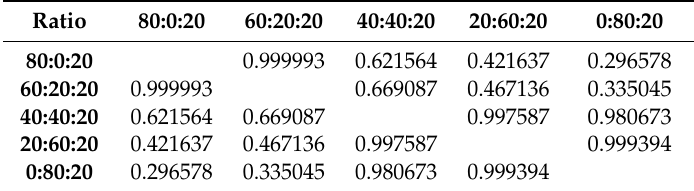
Table 9. p -valuesofTukeypost-hoctest: statisticalsignificanceofthedifferencesinthegraphinFigure6right. Table 9. p-values of Tukey post-hoc test: statistical significance of the differences in the graph in Figure 6b.